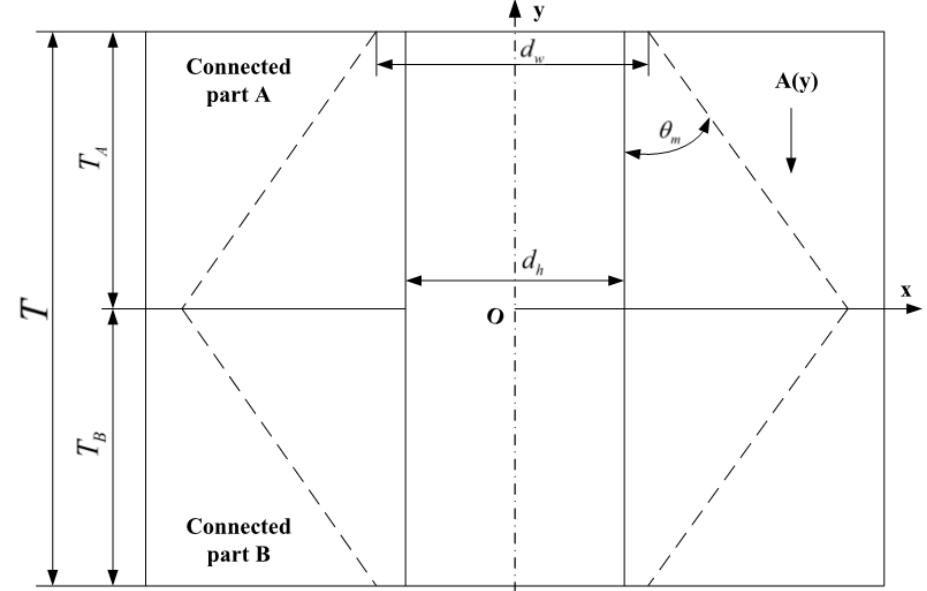
Figure 8. Axial variation of the area of the pressurized layer of the connected parts. The stiffness of the connected member changes with the area of the compressed layer, which is mainly determined by the elastic modulus of the material and the thickness affecting the cone angle θ m , and the equation fitted in the joint literature [20] establishes the relationship between the elastic modulus and the thickness causing the cone angle θ m change, as in Equation (5).